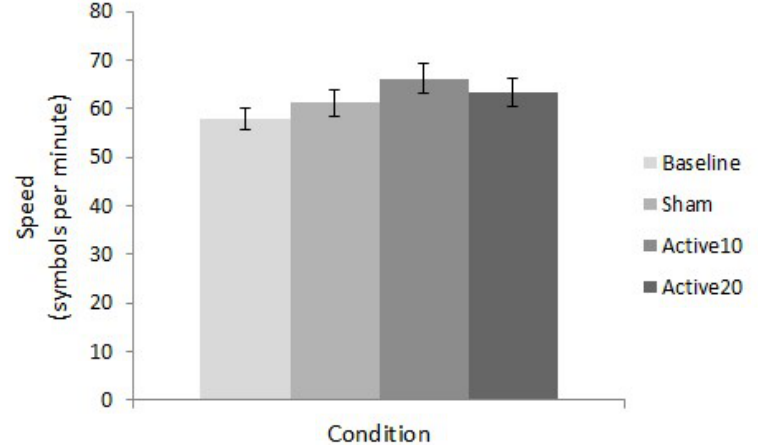
Figure 2. STAC final speed. Mean speed values for all conditions (baseline, sham, Active10, Active20) illustrate superior task performance following 10 min of anodal tDCS. Error bars represent ±1 standard error.